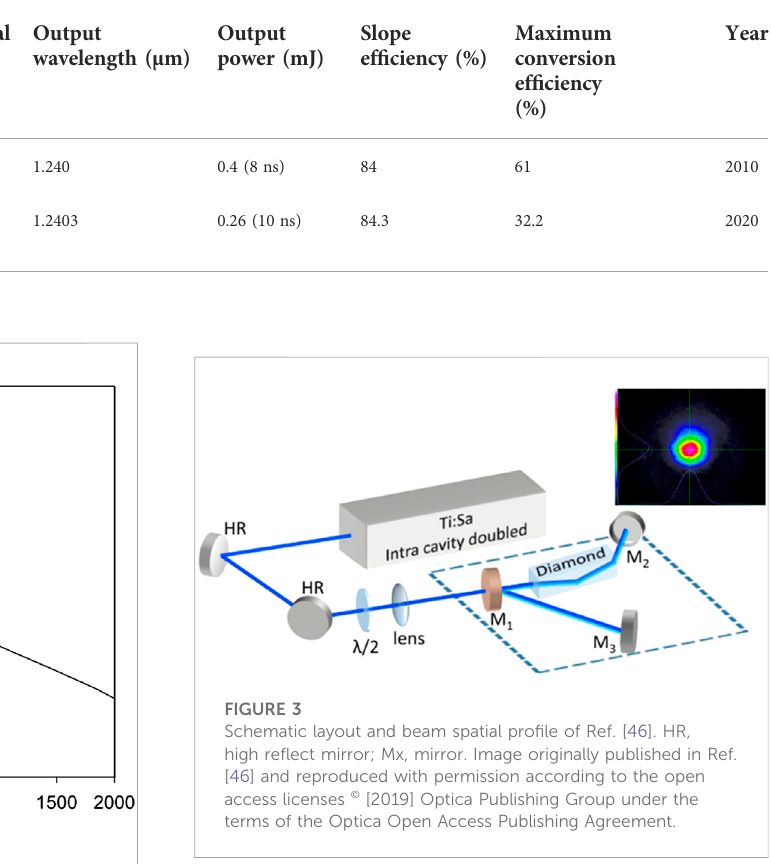
TABLE 2 Summaries of ns-pulsed DRLs operating near the quantum limit.